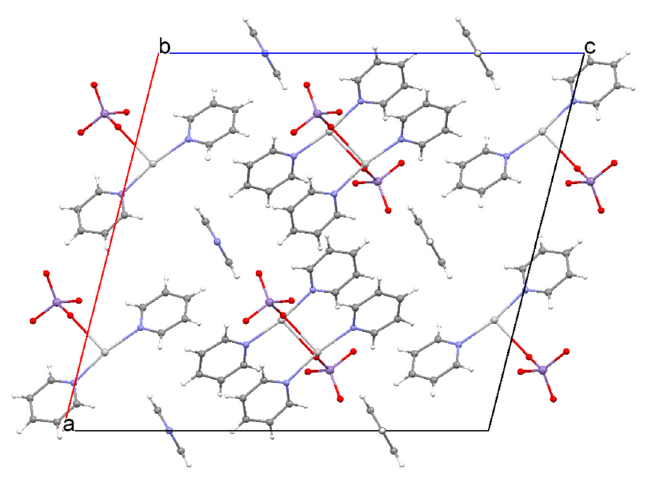
Figure 7. Structure and packing of compounds 3a and 3b [9].